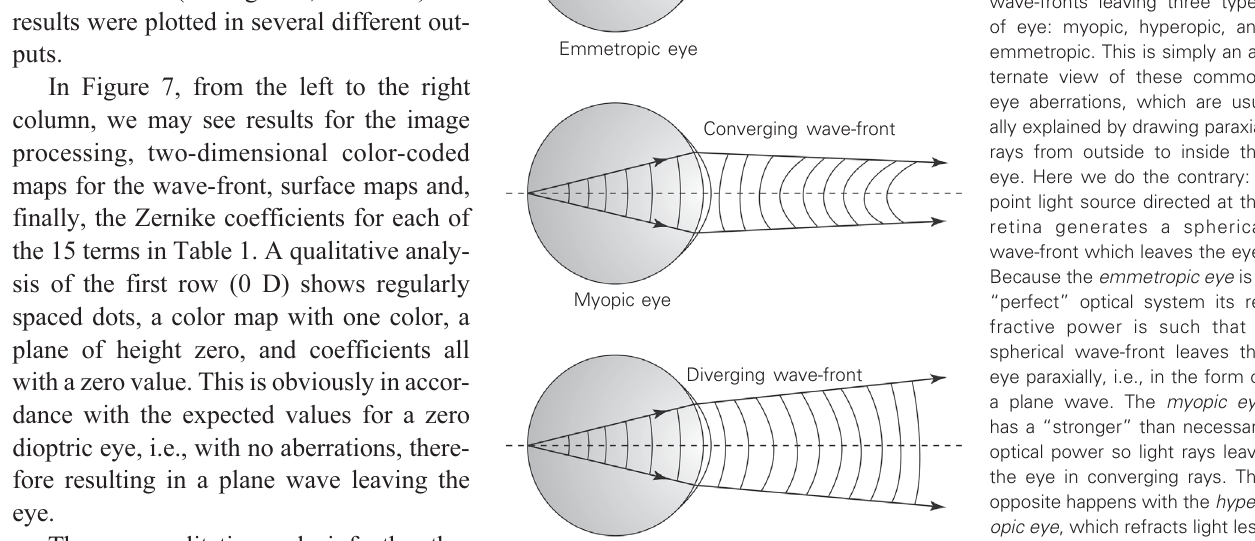
Figure 8. Differently shaped wave-fronts leaving three types of eye: myopic, hyperopic, and emmetropic. This is simply an al- ternate view of these